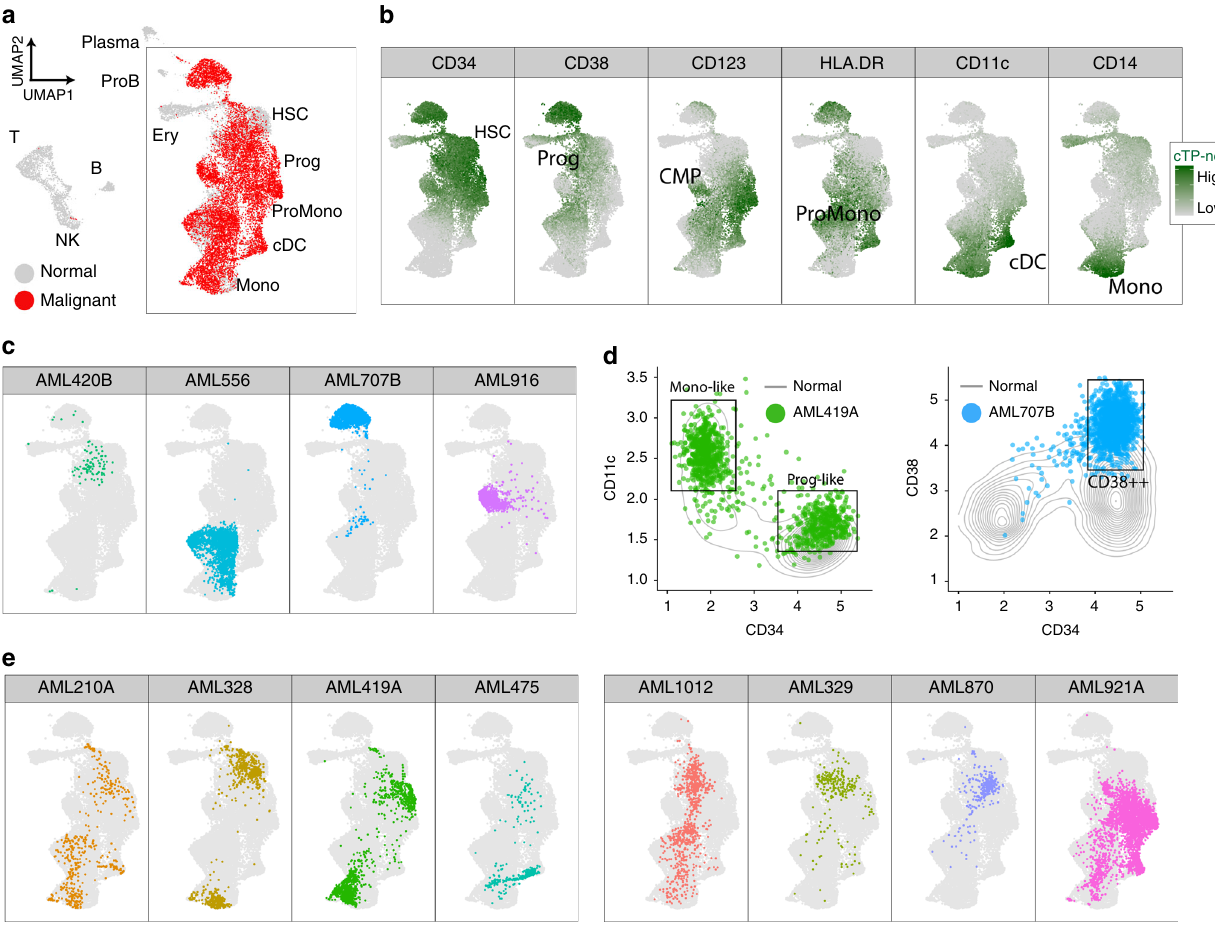
Fig. 4 Imputation results analysis on acute myeloid leukemia data sets. a UMAP visualization of normal cells and malignant cells from 12 AML samples at Day 0 based on imputed protein abundance (red: malignant cells; gray: normal cells). b UMAP visualization of the myeloid trajectory. cTP-net imputed protein abundance of markers that perfectly recapitulate the myeloid development. c , e , f UMAP visualization of the myeloid trajectory with corresponding malignant cells from AML sample highlighted. d Plot of normal cells (gray contour) and AML malignant cells (dots) based on imputed protein